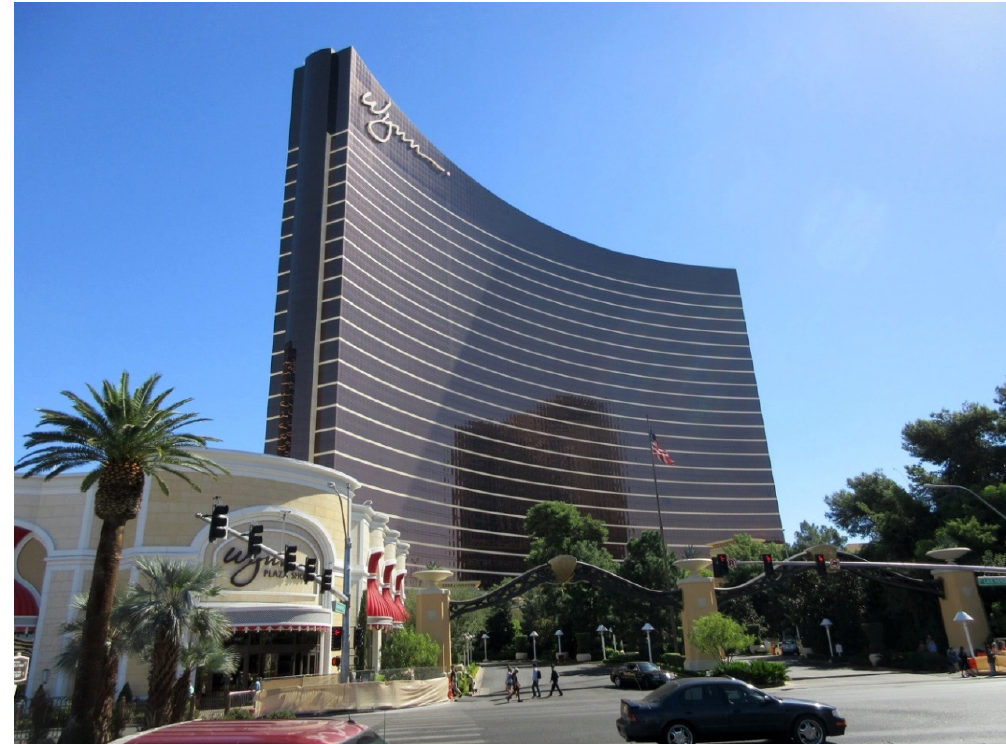
Figure 8. View of the front of the Wynn Las Vegas. Compare the size and style of its design with the Desert Inn in Figure 5. Source: Aseem Inam.